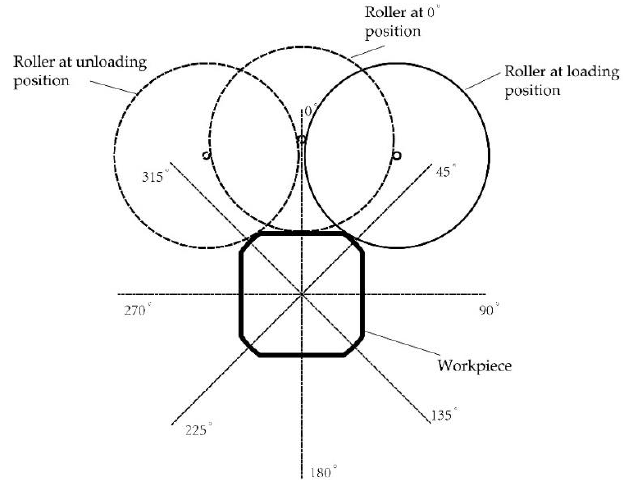
Figure 4. Schematic drawing of the non-circular spinning process stages.